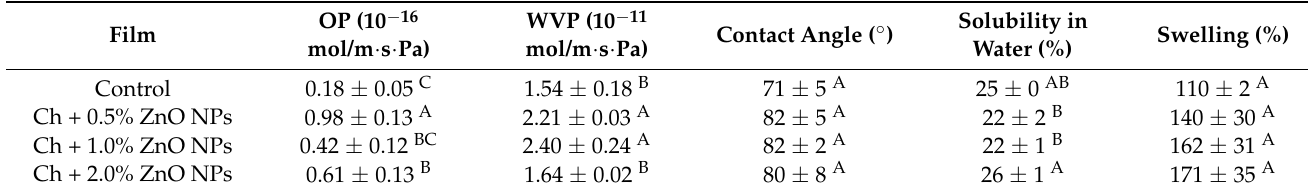
Table 2. Barrier and hydrophobicity